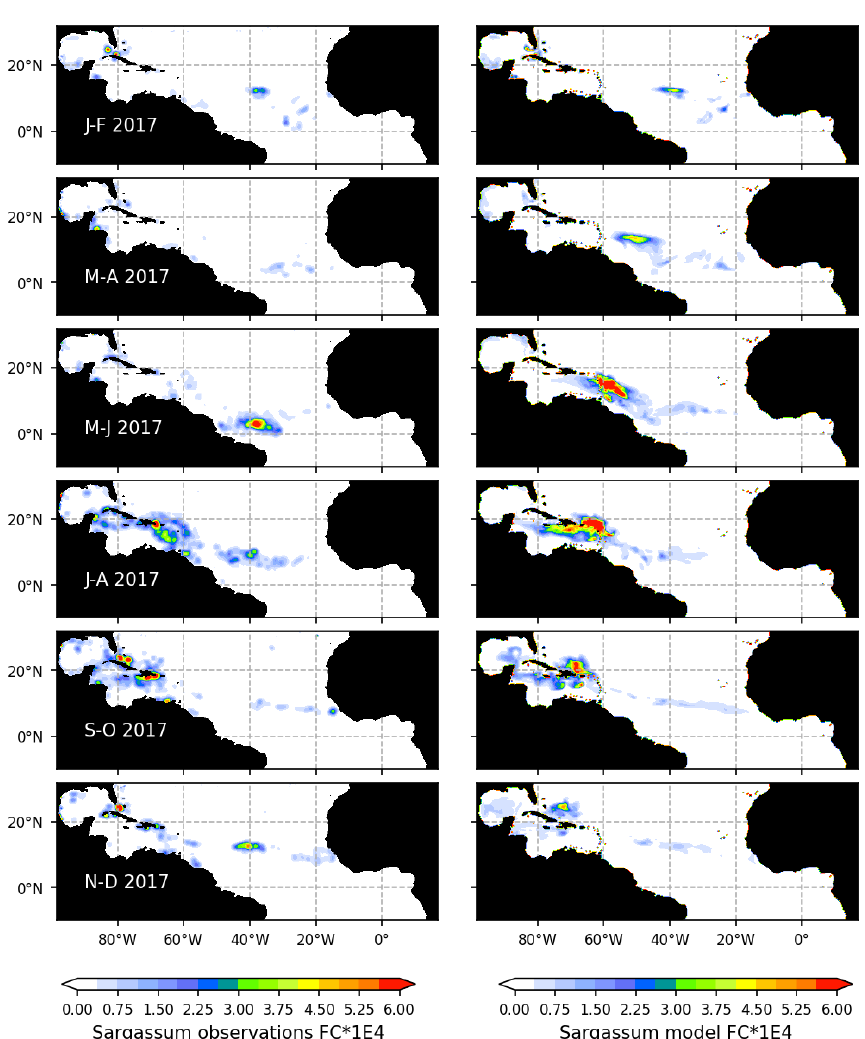
Figure 4. Seasonal distribution of Sargassum fractional coverage for the year 2017 from observations (left) and from a selected ensemble of 100 simulations ( (cid:127) 100 ) with varying parameters